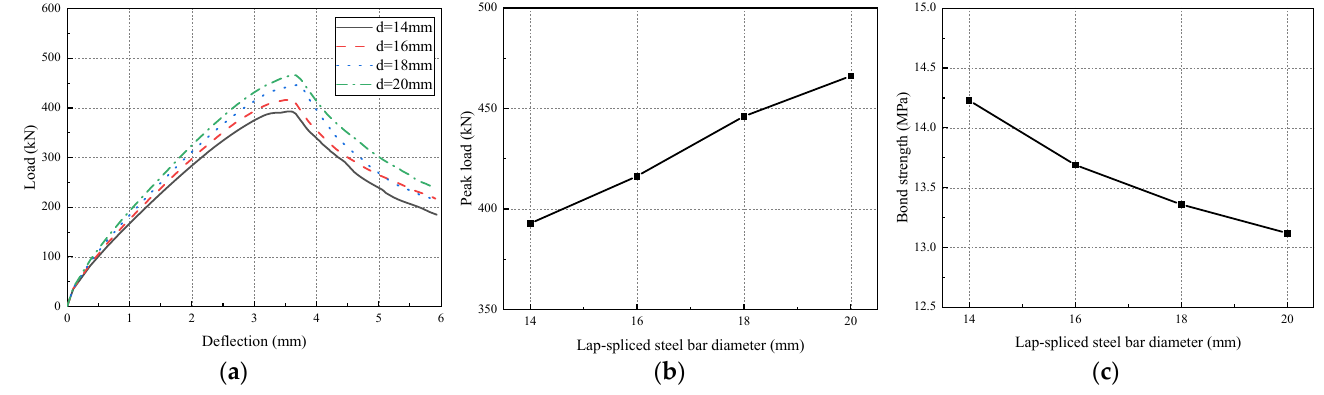
Figure 18. Influence of lap ‐ spliced steel bar diameter: ( a ) load–deflection curve; ( b ) peak load; ( c ) bond strength.